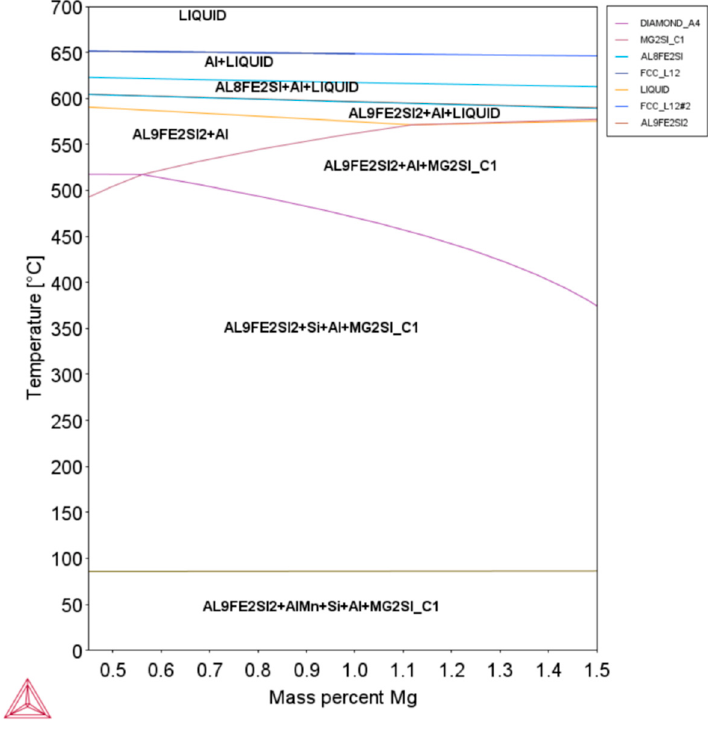
Figure 2. Equilibrium pseudo-binary Al-Mg phase diagrams, with constant Si concentration equal to 0.6 wt.% for ( a ) and 1.1 wt.% for ( b ).